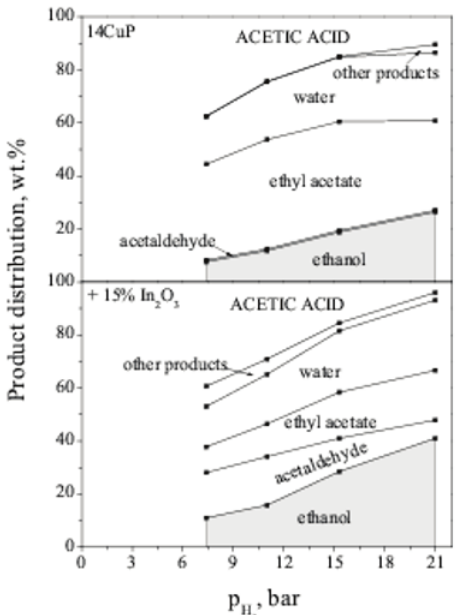
Figure 7. Product distribution of 14CuP and 15In O /14CuP 2 3 /He mixture as function catalysts in the conversion of AA/H 2 of AA partial pressure at 21 bar total pressure and 340°C. The WHSV of AA was 1.0 h -1 . Constant partial pressure of H was 11 bar. The AA partial pressure was changed by 2 /He ratio. changing the AA/He 2